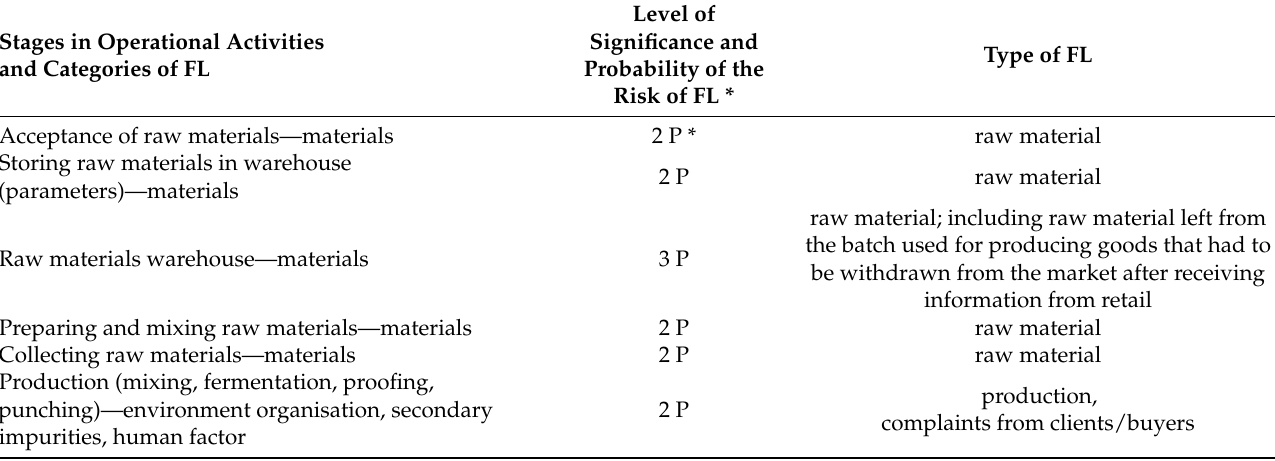
Table 6. Assessment of the significance and likelihood of food loss risks and their nature in the subsequent operational activities in